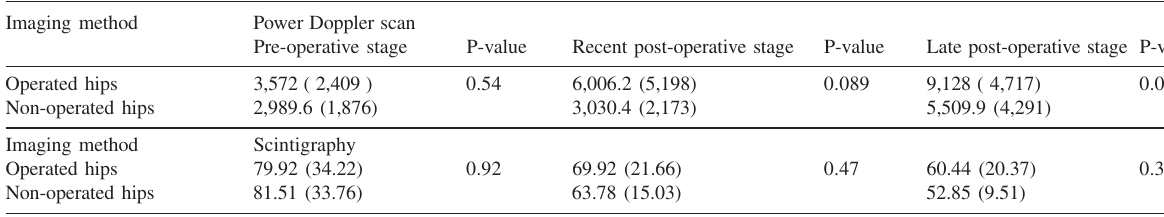
Table - Mean (standard deviation) number of pixels measured in the proximal femora are reported pre-operatively, and at 1 (recent post-operative) and 6 (late post-operative) weeks after a unilateral intertrochanteric femoral osteotomy in rabbits that underwent power Doppler and scintigraphic examinations. Mean (standard deviation) vascular fractional area and number of vessels / area unit measured in the proximal femoral epiphyses with histomorphometric methods in the late post-operative (after 6 weeks) stage are also shown.